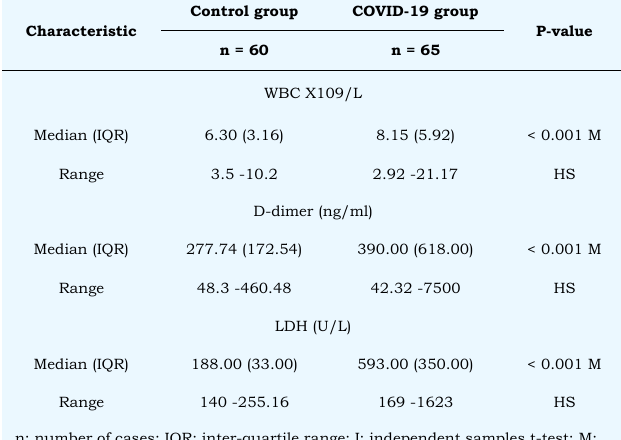
Table 2 Comparison of markers of inflammation between patients with COVID-19 and healthy control subjects Control group COVID-19 group Characteristic